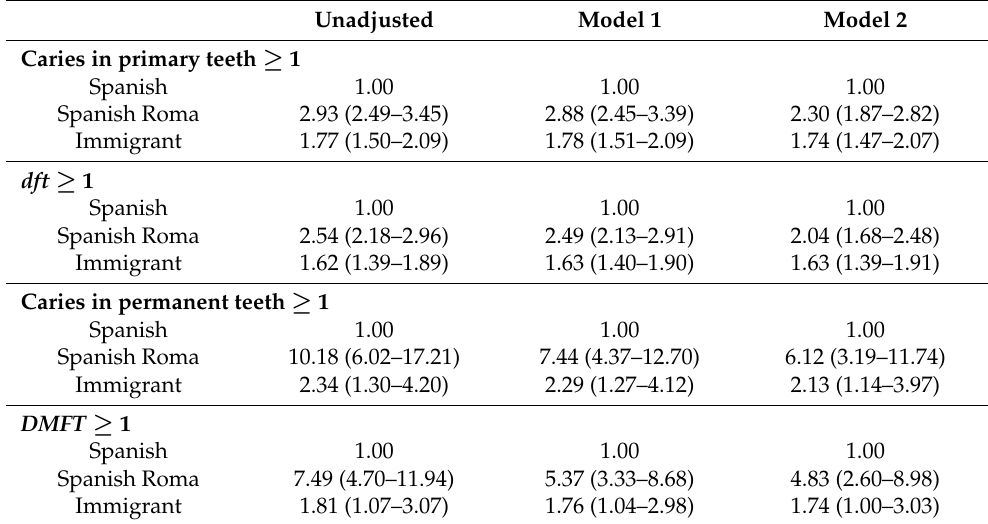
Table 2. Prevalence Ratios and their 95% Confidence Intervals of dental caries outcomes for parental migratory status/ethnicity: Children’s Oral Health Survey, Municipality of Bilbao, 2017.